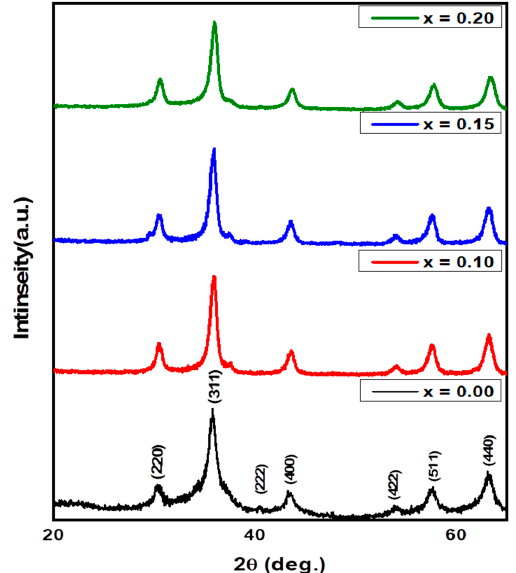
≤ x ≤ 0.2) nanoparticles x Fe 2 − x O 4 (0.0